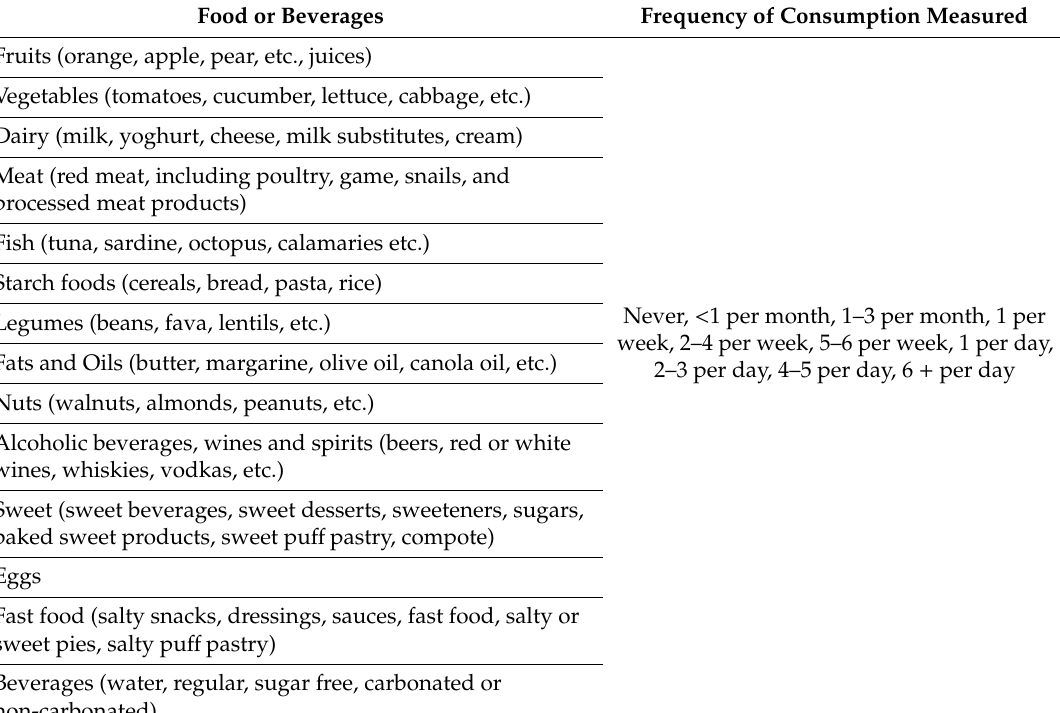
Table 1. Basic Foods and beverages included in the food propensity questionnaire (FPQ) used. Food or Beverages Frequency of Consumption